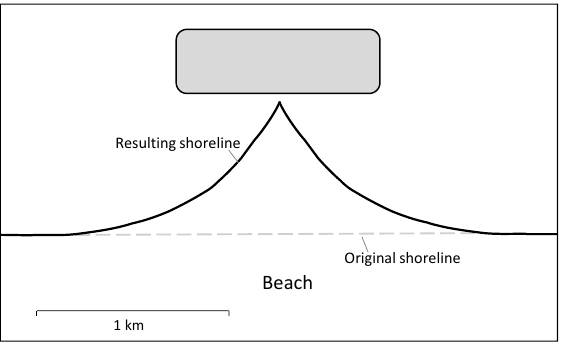
Figure 9. Expected beach profile of an offshore structure close to the coastline (extreme scenario) [33].